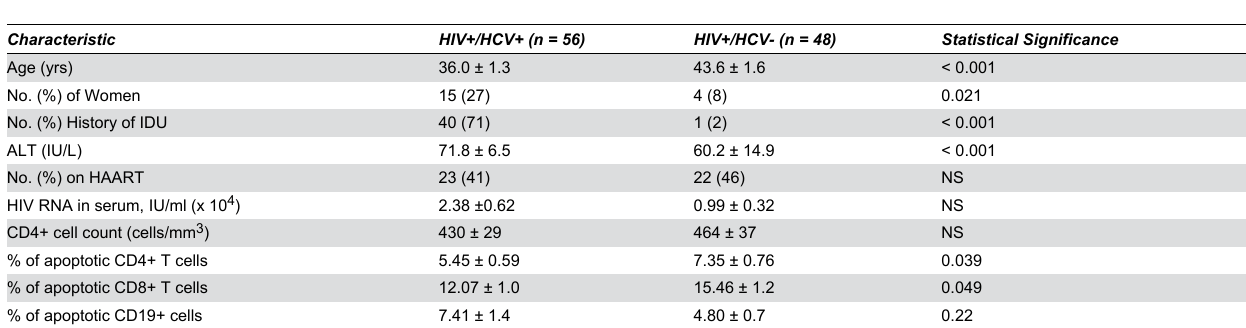
Table 1. Characteristics of HIV/HCV coinfected patients as compared to HIV-monoinfected patients